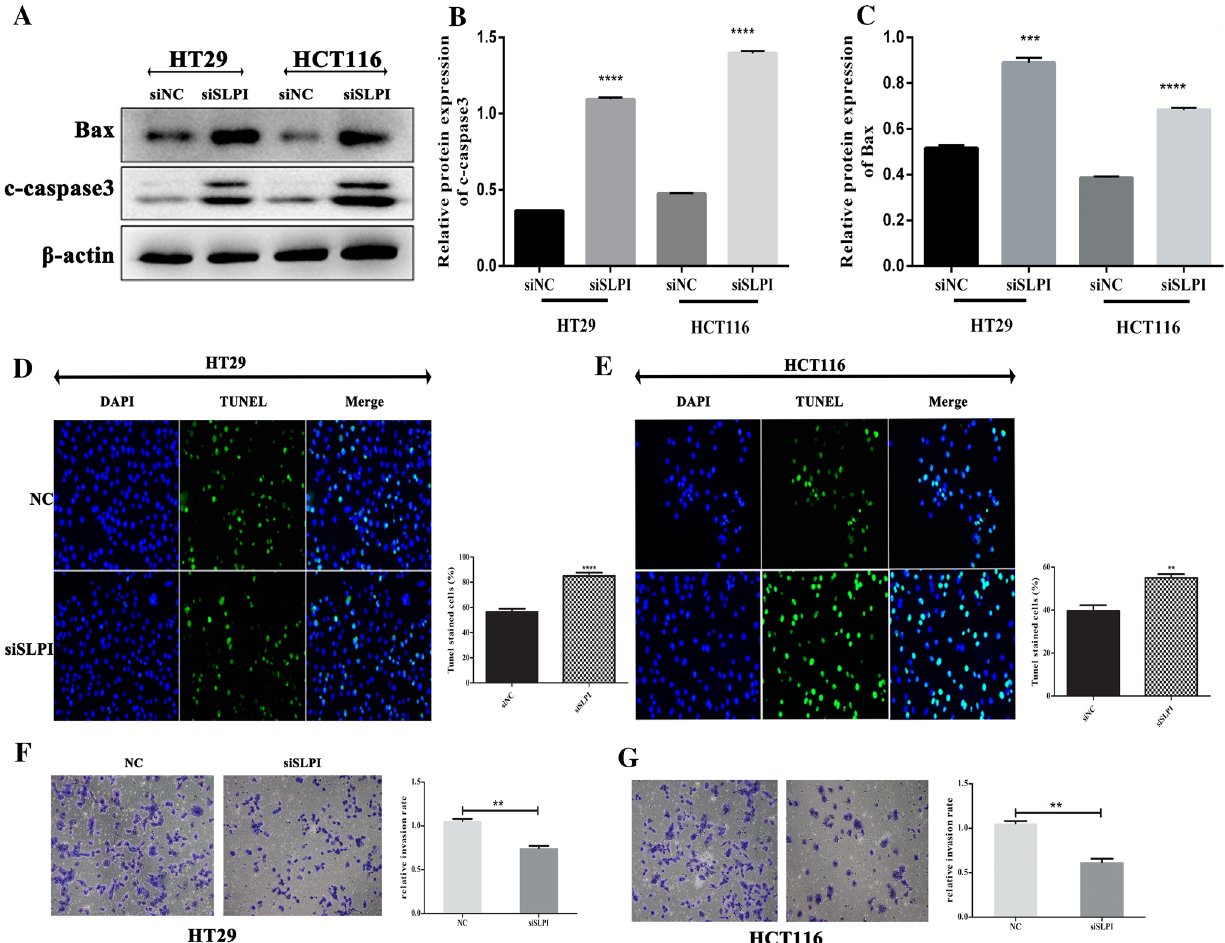
Fig. 3 Puma can increase the level of apoptosis. Western blot results exhibited how inhibition of SLPI led to elevated expressions of both BAX protein and clavated-caspase 3 ( A – C ). The Tunel results confirmed the presence of significant apoptosis reaction in colon cancer cells in response to SLPI inhibition ( D – G ). Images were taken from three random groups, and TUNEL-positive cells were counted, and the percent- age was calculated for HT29 and HCT116 cells. Tune-positive cells were found in calculated and *p < 0.05; ***p < 0.1, and ****p <